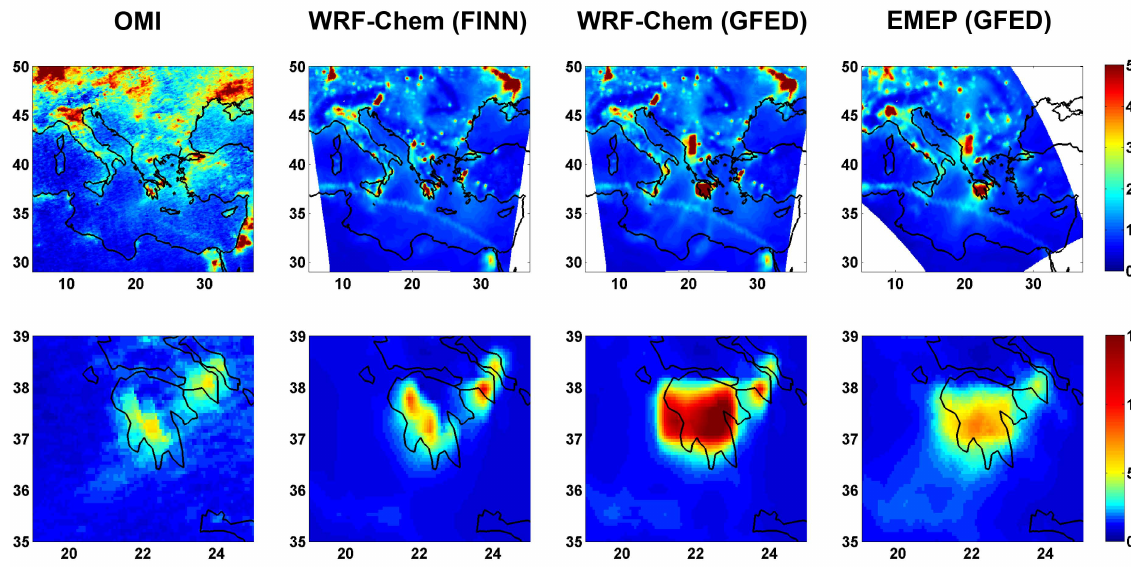
Fig. 7. Tropospheric columns of NO 2 (10 15 molec cm − 2 ) as retrieved from the OMI satellite instrument (1st column), and as modelled with the WRF-Chem (2nd and 3rd columns) and EMEP (4th column) models, averaged over the period 21–28 August 2007 (corresponding to the 8-day period in the GFED data set). In the second column, FINN forest fire emissions have been used in the simulations, while in the two rightmost columns, GFED emissions have been used. The bottom plots have different colour scale and are zoomed in on the Peloponnese